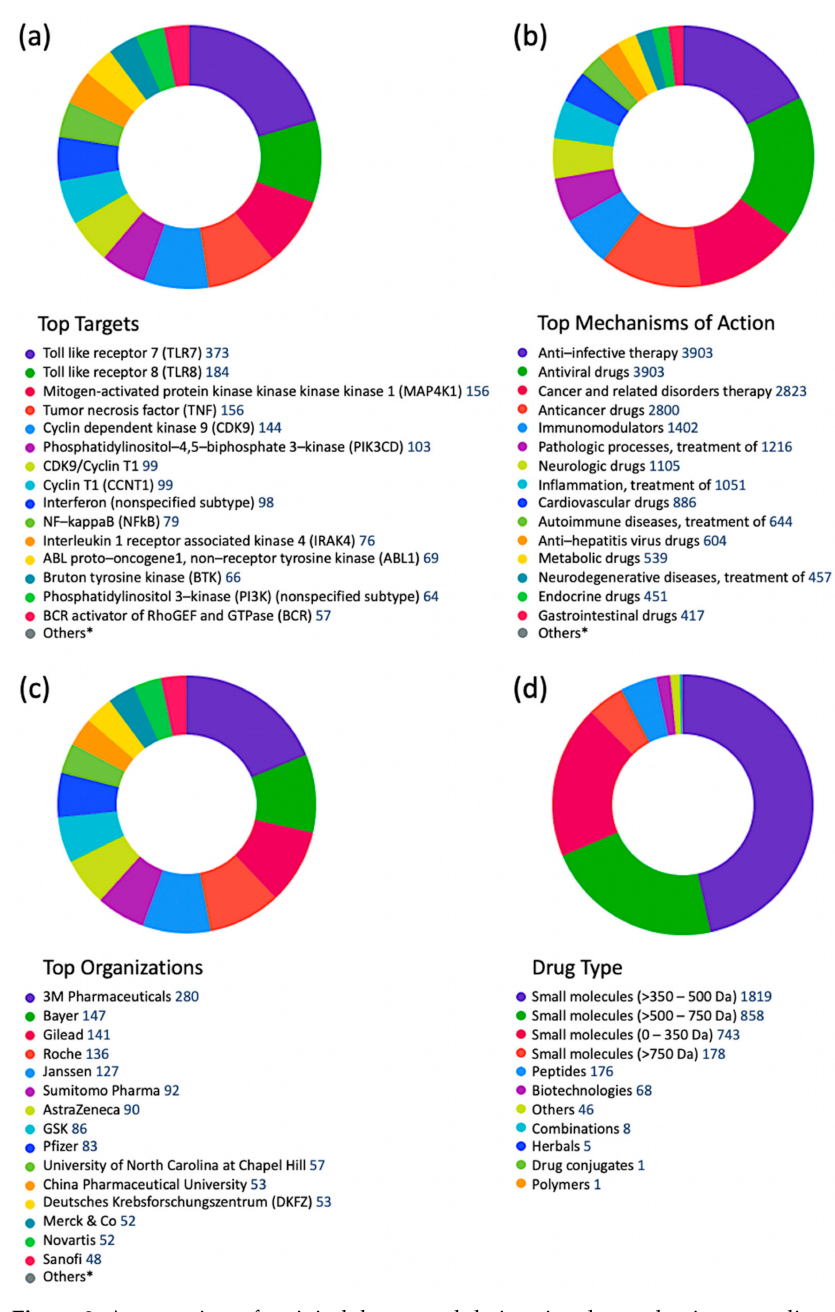
Figure 3. An overview of antiviral drugs modulating signal transduction according to ( a ) top targets, ( b ) top therapeutic groups, ( c ) top organizations, and ( d ) drug types. * Others in ( a – c ) indicate